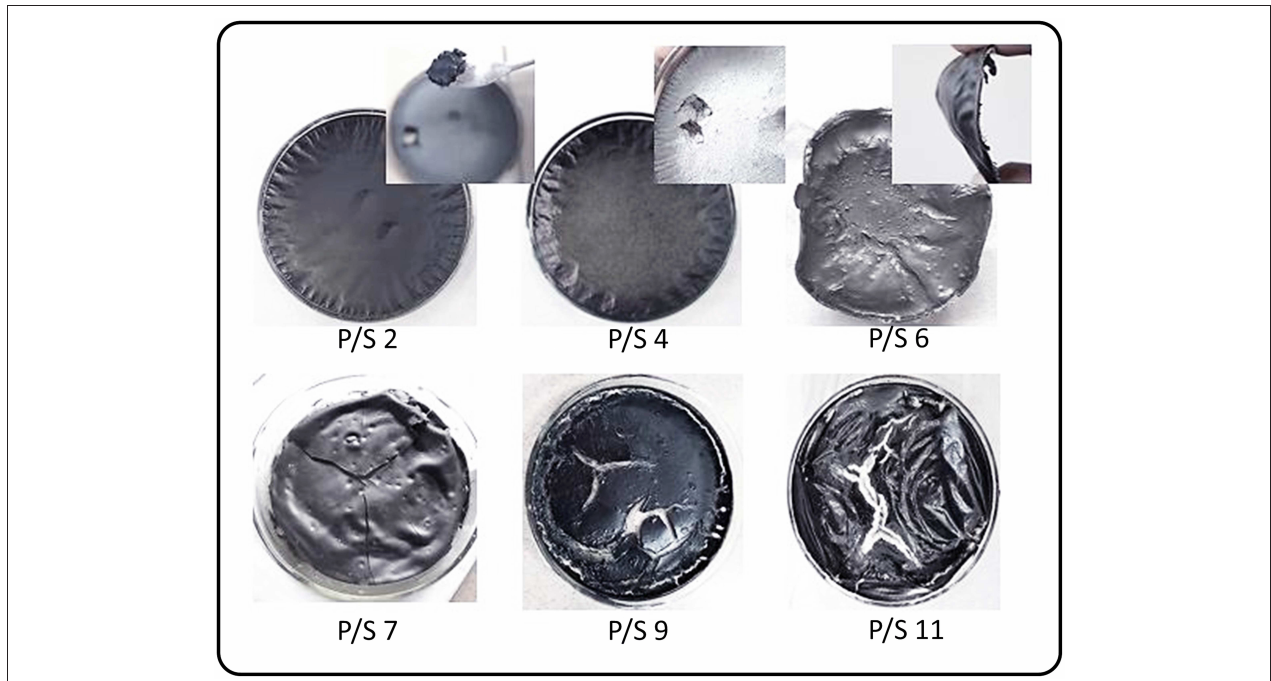
FIGURE 1 | Digital images of PANI/Sago films at different pH.